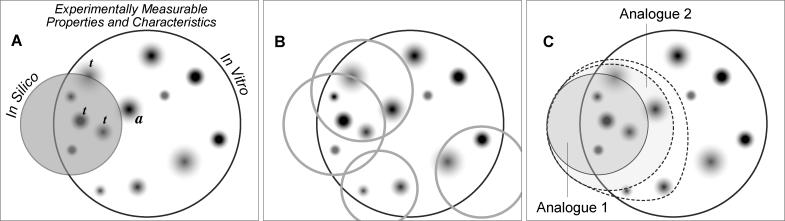
A Process for Iterative Refinement of Biological ModelsAn abstract Venn-like diagram illustrates the behavior similarities (depicted as overlapping sets of features) of in silico and in vitro models.(A) The shaded circle contains the set of observable, measurable attributes (qualities, properties, etc.) of an in silico model such as Analogue 1 or 2. The larger circle is the infinite set of possible observable, measurable attributes of an in vitro model that is being viewed or studied from a particular perspective, with attention focused on selected aspects of the system. a: Each small shaded domain represents the results of wet-lab experiments intended to measure a specific in vitro property or characteristic. The degree of shading illustrates different levels of experimental and measurement uncertainty. t: a member of the set of targeted in vitro attributes that the in silico model is expected to mimic.(B) This sketch illustrates that it may take many different in silico models, possibly drawn from different classes of models, to obtain even partial behavior coverage of the in vitro system.(C) Illustrated is the systematic, sequential extension of the in silico analogue's measurable attributes to improve coverage. The original shaded set can illustrate Analogue 1. The first dashed circle illustrates expanding the original set of targeted attributes by including one or more additional properties. The established analogue (Analogue 1) fails to generate the required outcomes, resulting in its invalidation. A copy of the established analogue can be iteratively refined (without losing or breaking the original behaviors) by adding new details as needed. The goal is to have all of the expanded set of targeted attributes (original plus expanded coverage) adequately represented by a new analogue, such as Analogue 2, represented by the first dashed circle. The process can be repeated indefinitely by adding attributes to the target set and then adding new capabilities to Analogue 2 as before. With each extension, the goal is to have the expanded set of targeted attributes all adequately represented. If the goal cannot be achieved without “breaking” the original model, then either a new model or multiple separate models, as in (B), may be required.